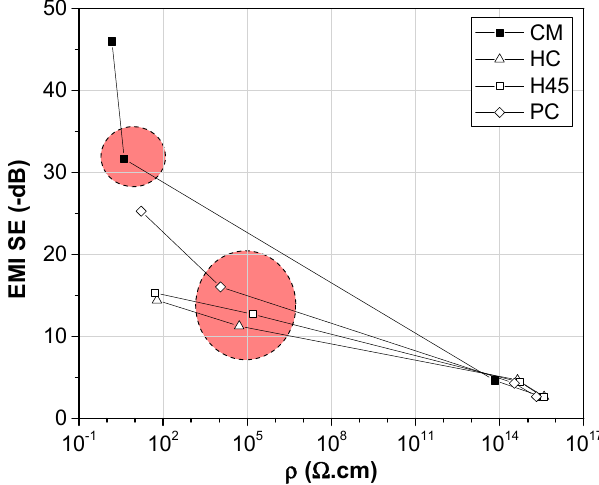
Figure 11. Electromagnetic shielding vs. resistivity of neat ABS, and different GNP, CNT, and hybrid nanocomposites (red circles) at 6 wt.% produced by compression molding (CM) or by 3D printing.